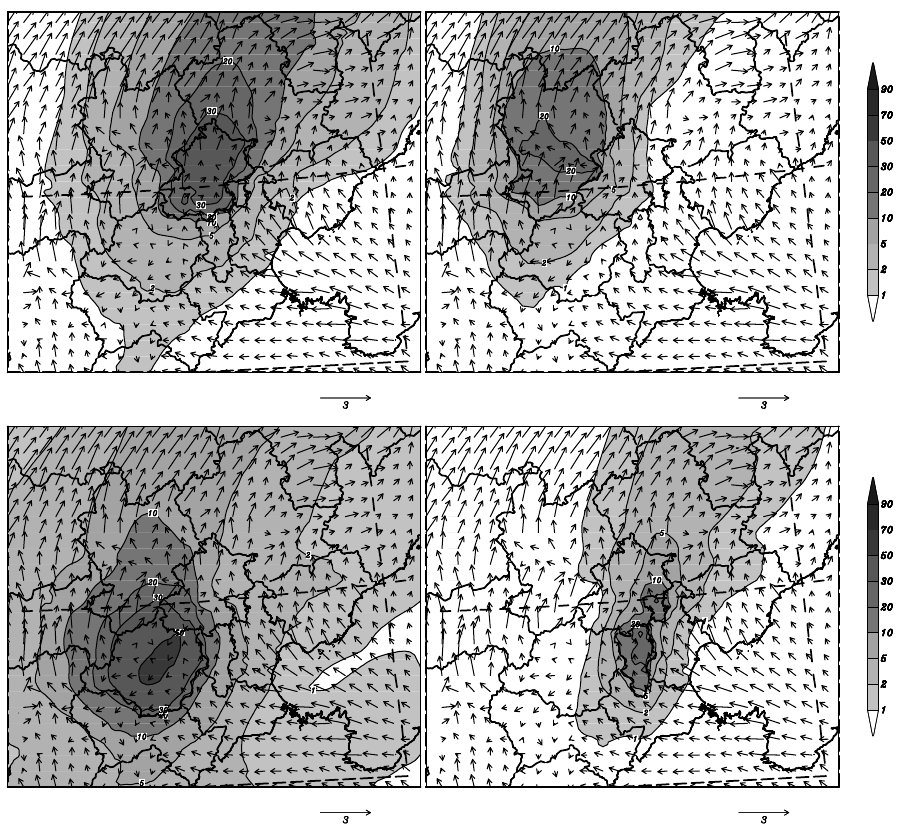
Fig. 13. Horizontal distribution of the percentage of Beijing local production and potential surrounding areas contributions to ozone monthly mean concentration over Beijing: upper left: from BJ; upper right: from ZJK; lower left: BD; lower right: LF. The unit of the wind vector is m/s.